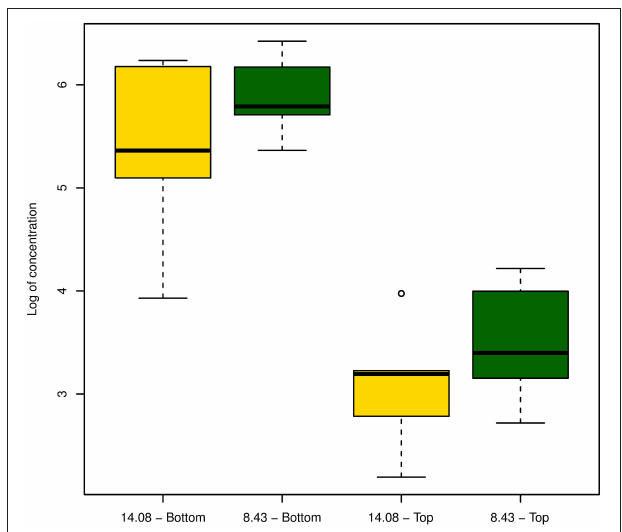
FIGURE 5 | Boxplot of the estimated bacterial population in the upper (Top) and lower (Bottom) part of the stem 10 days after inoculation with strains CRAFRU 8.43 and CRAFRU